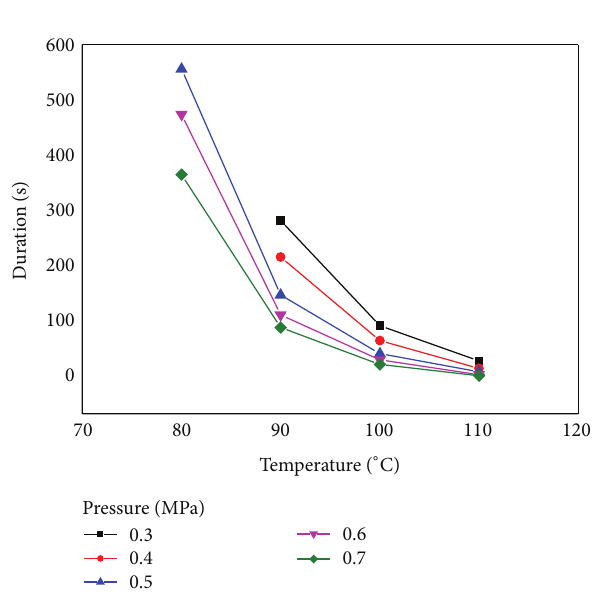
Figure 11: Durations to complete the